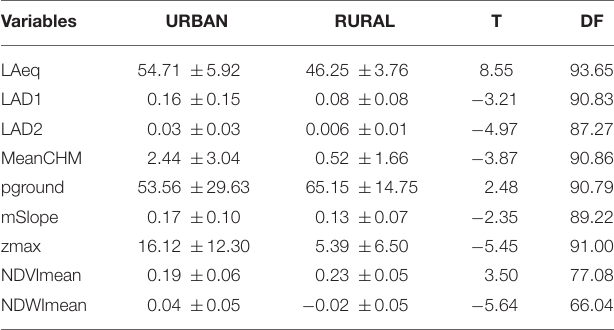
TABLE 4 | Mean and SD for ecological variables for urban and rural samples with results from Welch’s t -tests for each variable. Variables